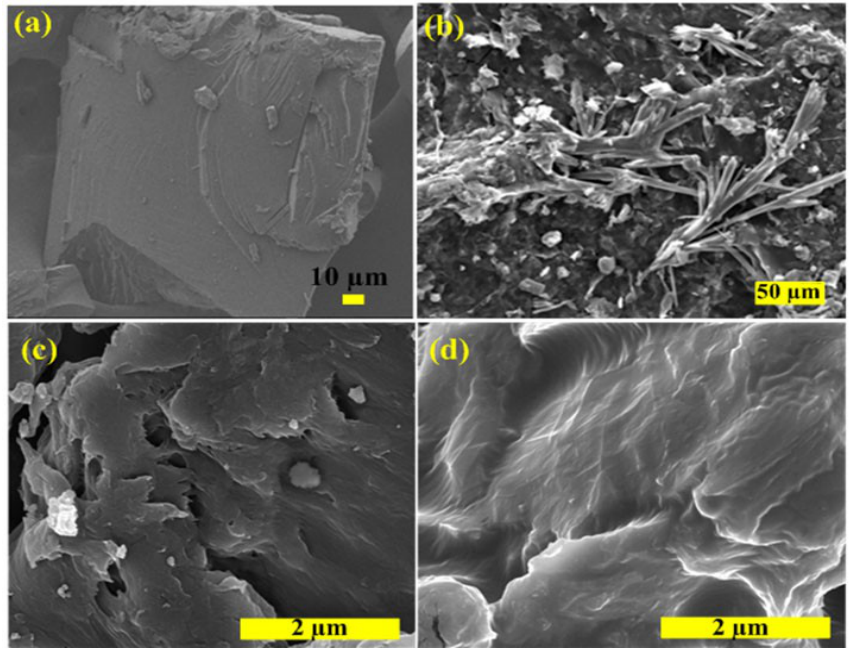
Figure 4. The SEM micrographs of ( a ) neat PSTY; ( b ) GO-PSTY; ( c ) RGO-PSTY and ( d ) R-(GO-PSTY) composites.